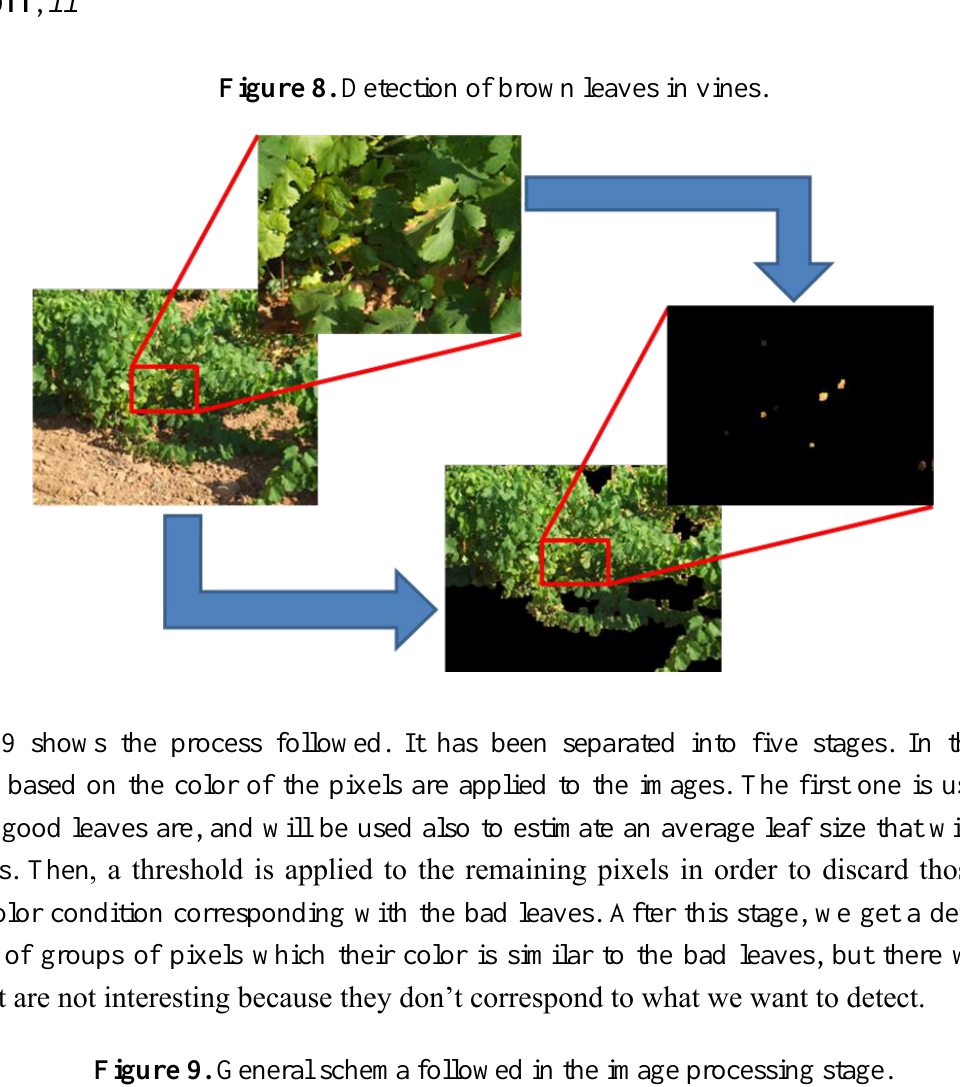
Figure 9. General schema followed in the image processing